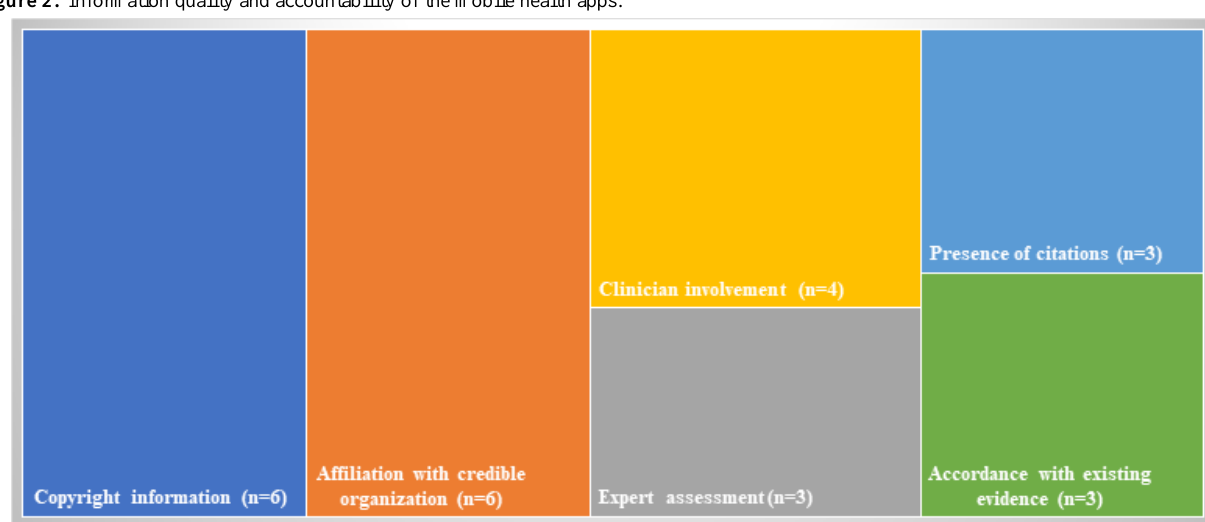
Figure 2. Information quality and accountability of the mobile health